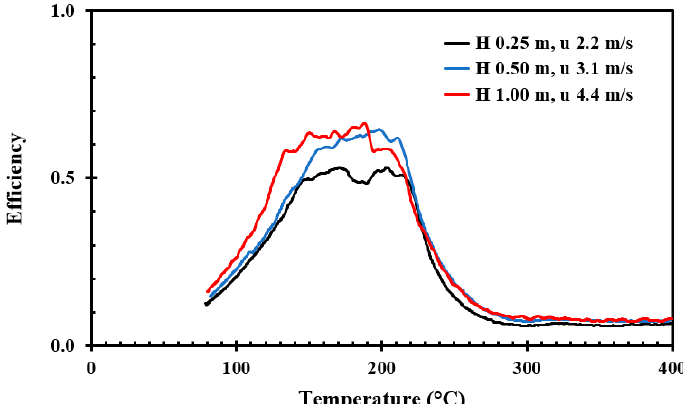
Figure 9. Cooling efficiency for pure water droplets at horizontal disc orientation, droplet diameter 2.5 mm. Impingement heights and speeds are given in the figure label.